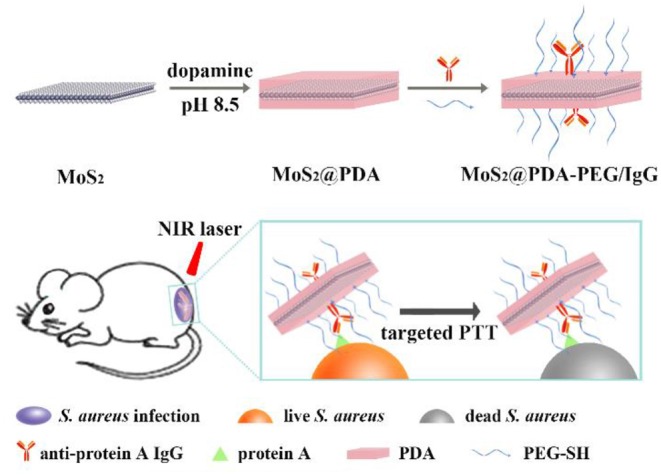
The preparation of MoS2@PDA-PEG/IgG NSs (MPPI NSs) and their application for targeted PTT of S. aureus focal infection.